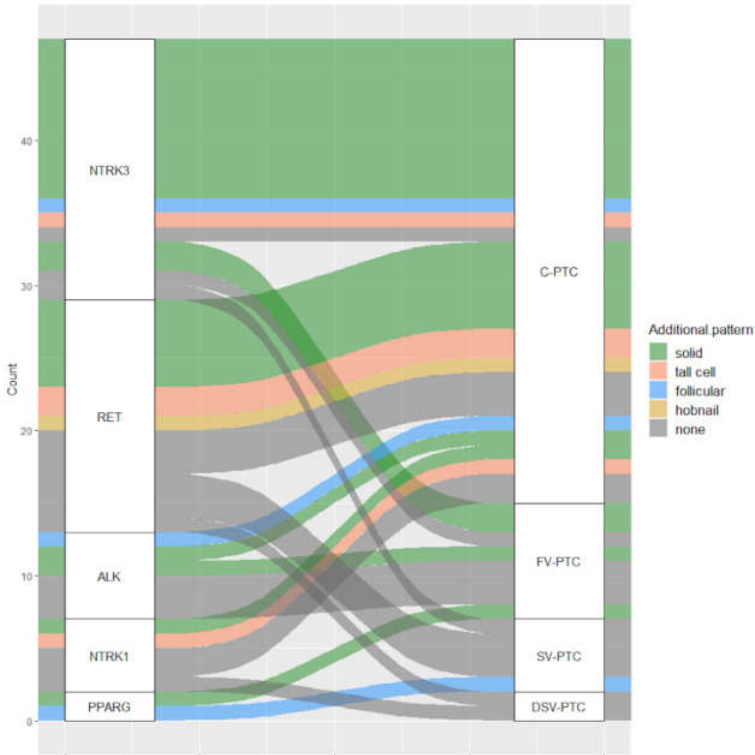
Figure 3. Alluvial plot representing fusion-positive PTC. Correspondence between rearranged gene, PTC variant and presence of histological growth patterns (additional pattern) is shown. The case of PTC lymph node metastasis with no primary tumor has been excluded from this plot. Abbreviations: C-PTC, classical papillary thyroid carcinoma; FV-PTC, follicular variant papillary thyroid carcinoma; SV-PTC, solid variant papillary thyroid carcinoma; DSV-PTC, diffuse sclerosing variant papillary thyroid Table 2. Statistical comparison between fusion-driven and point mutation-driven pediatric PTCs.